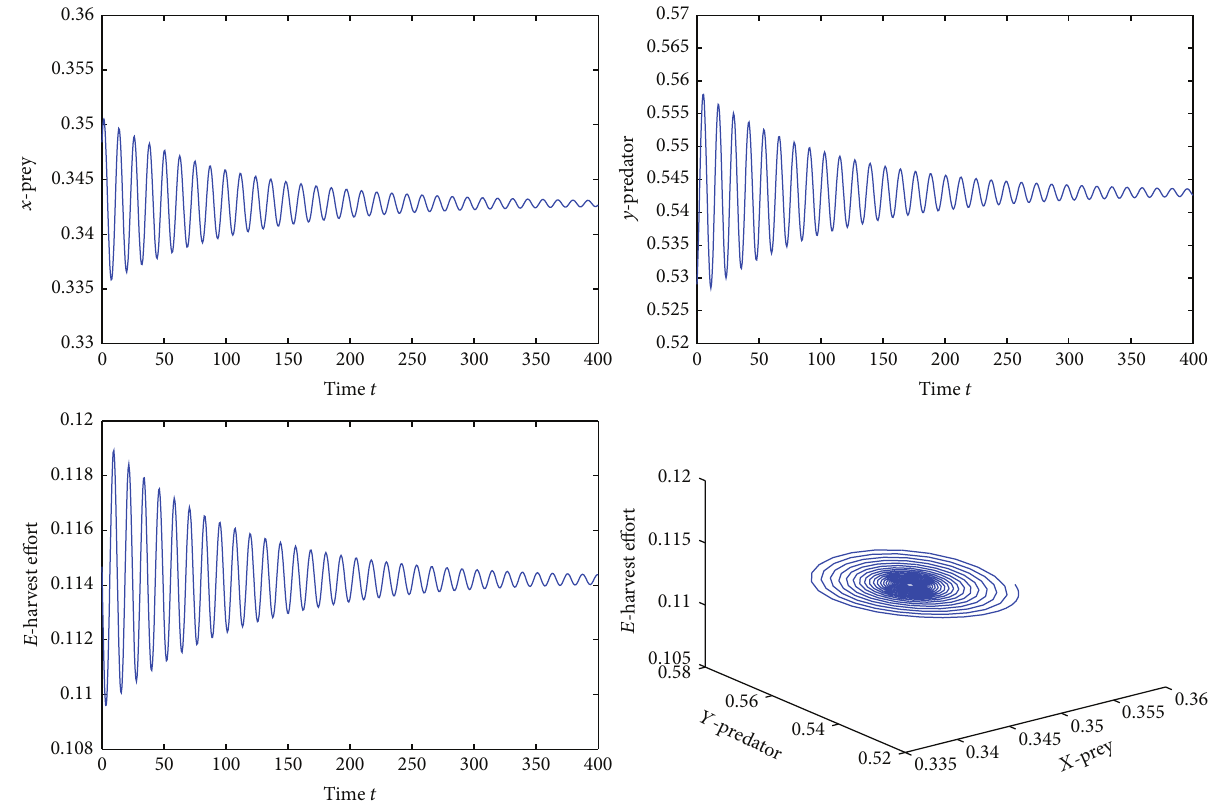
Figure 1: When 𝜇 = 0.155 < 𝜇 0 , the positive equilibrium point 𝑋 0 (𝜇) is locally asymptotically